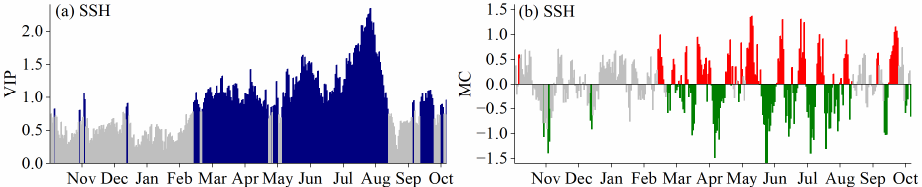
Figure 10. Results of partial least squares (PLS) regression correlating the end of the growing season (EOS) from 1985–2018 with 31-day running means of climatic factors. ( a , b ) Sunshine hours (SSH) from the previous November to October of the year.